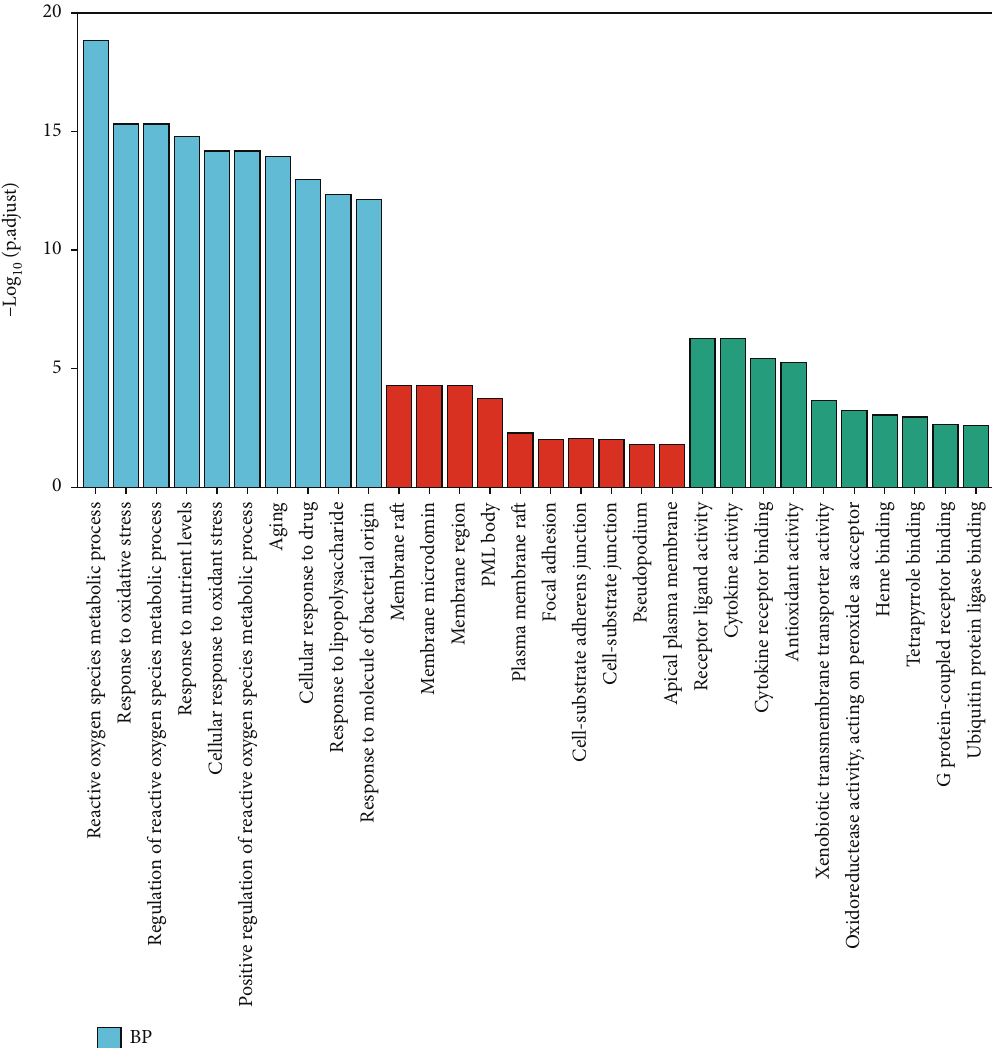
Figure 2: GO enrichment analysis of 46 intersection targets. The top 10 GO terms of biological process (BP), cellular component (CC), and molecular function